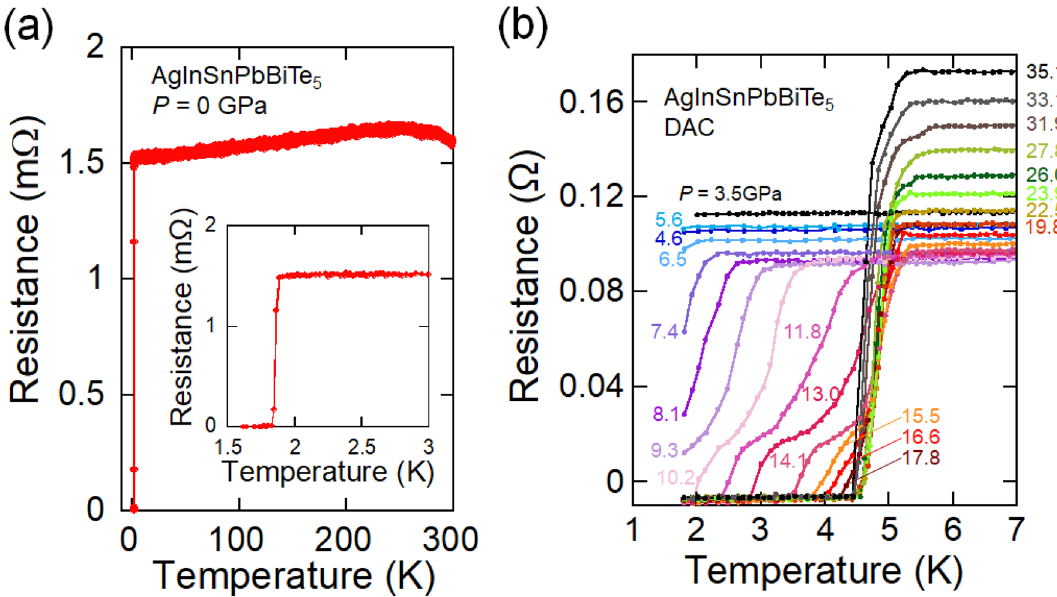
Figure 1. Superconducting transition in AgInSnPbBiTe 5 under high pressure. ( a ) Temperature dependence of electrical resistance of